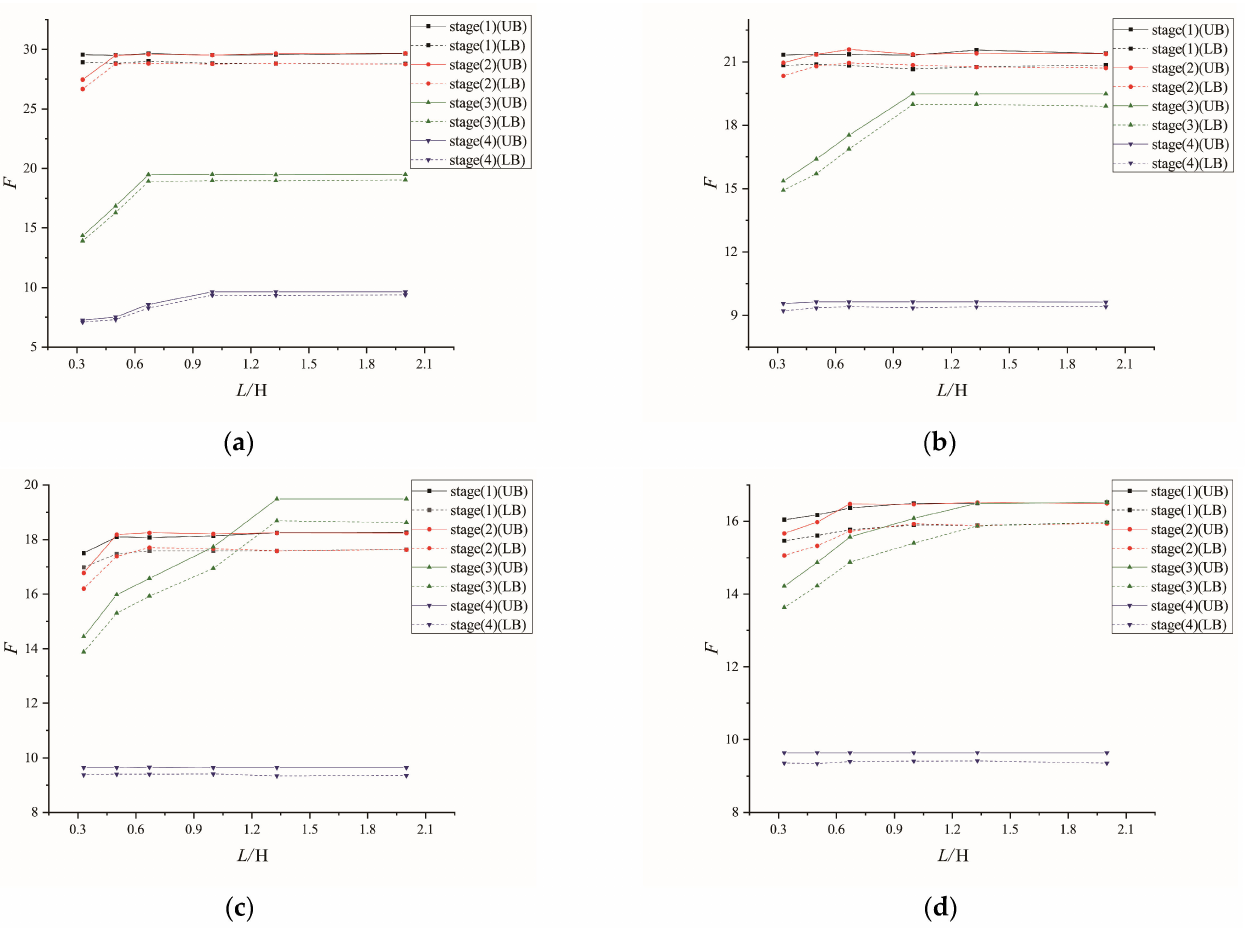
Figure 12. Influence of L on the safety factors F of global stability under different cover depth C of twin shield tunnels: ( a ) C = 0.5 H, ( b ) C = 1.0 H, ( c ) C = 1.5 H and ( d ) C = 2.0 H. According to the analysis in Section 3.1.1 above, the failure mechanisms under stage (1) and stage (2) are relatively similar. The twin shield tunnels collapse first under stage (1) and stage (2). As horizontal distance L increases, foundation pit will be outside failure zone of twin shield tunnels. In the following figures, the blue structures show the underground diaphragm wall and shield tunnels, respectively. The different colors of the shear dissipa- tion contours represent the value of the shear dissipation energy. The shear dissipation energy is larger when the color of the shear dissipation contours is more approximate to red. Besides, the green arrows represent the incremental displacement vectors of soils. Taking stage (2) as an example, the shear dissipation contours in Figure 13 and the